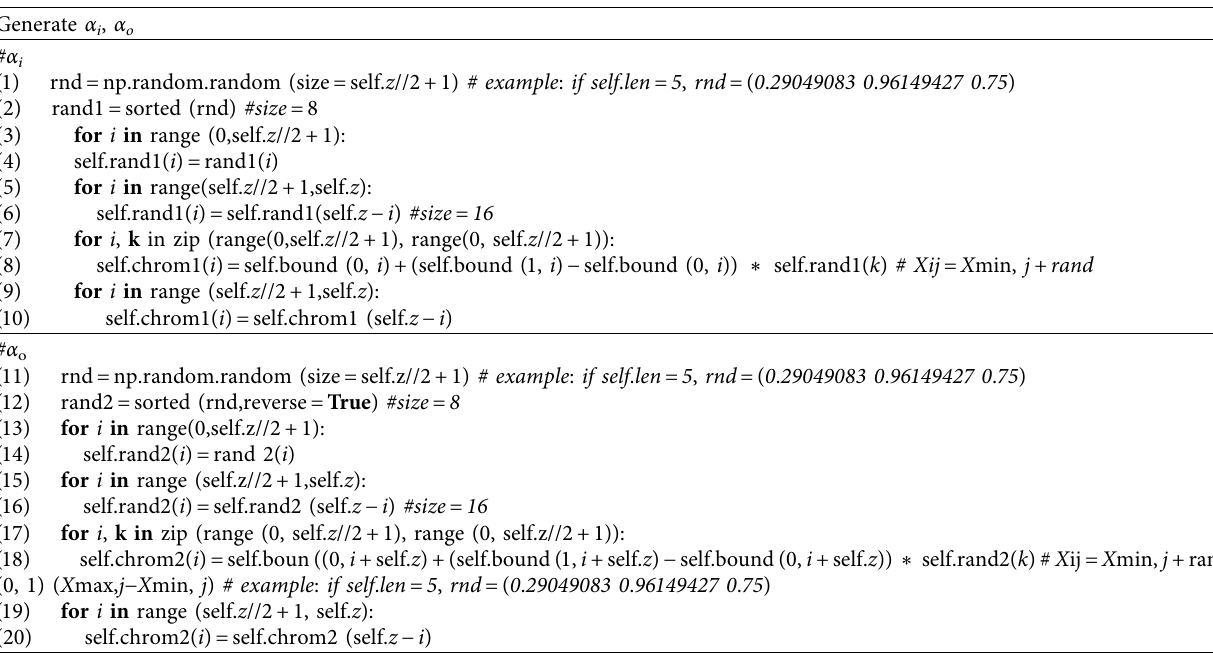
Table 2: Initialization phase algorithm structure adjustment of another part of the